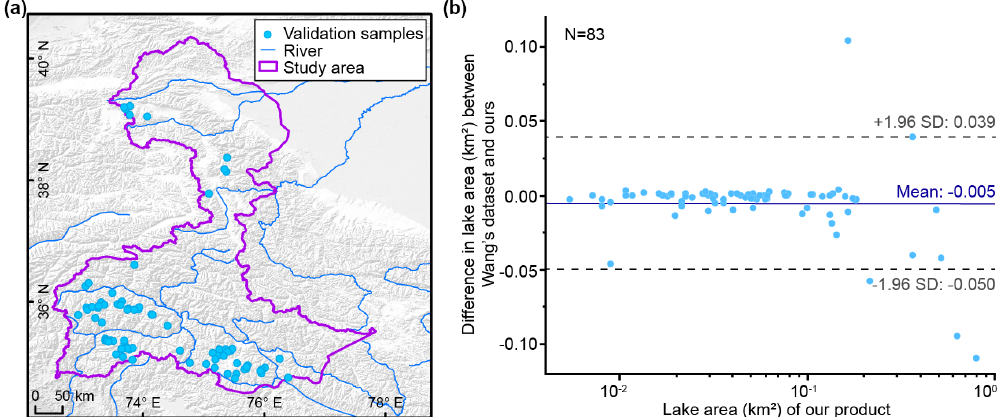
Figure A8. Distribution of validation samples (a) and comparison of glacial lakes (b) derived from our Landsat product in 2020 and Wang’s lake data in